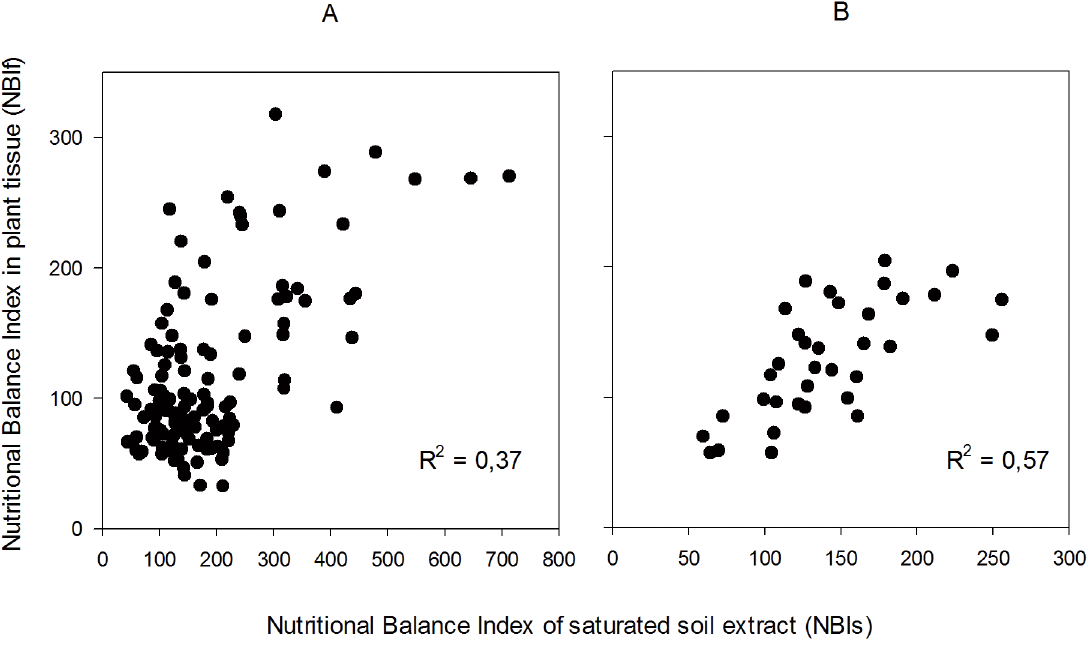
Fig 1. Correlations between NBIf (plant tissue) and NBIs (SSE) index. pH restriction. (A) pH range: 4.4 and 7.0. p < 0.001; n = 124. (B) pH range 5.8 and 6.2. p < 0.001;n = 35.